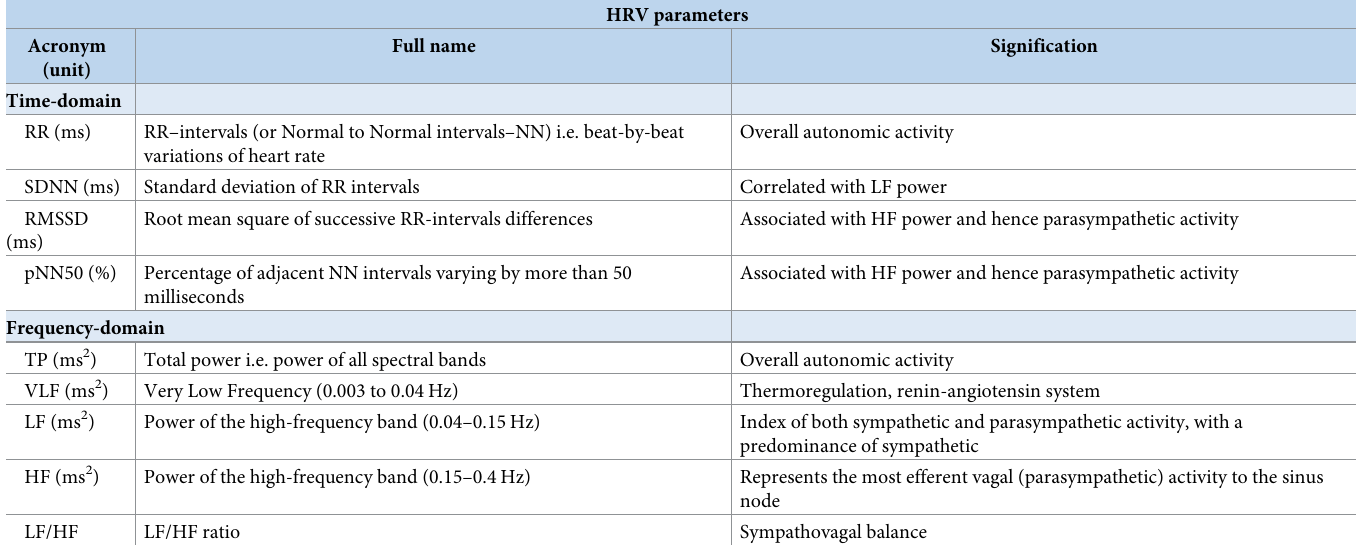
Table 1. Descriptive characteristics of HRV